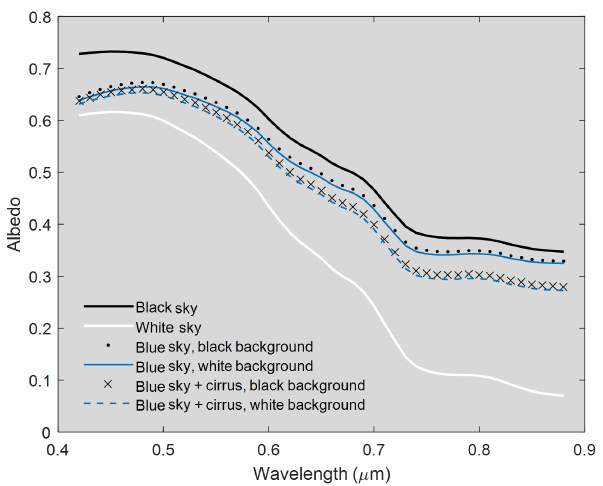
Figure 5. Typical spectral albedo of melt ponds, snow, and white ice, calculated for the following parameters: light pond – depth z is 20cm, σ t = 4m − 1 , H = 1 . 25m (transport optical depth is 5); dark pond – depth z is 20cm, σ t = 2m − 1 , H = 0 . 5m (transport optical depth is 1); white ice – the effective grain size is 2mm and optical depth is 12; snow – the effective grain size is 0.2mm and optical depth is 200 (see Malinka et al., 2016a, for